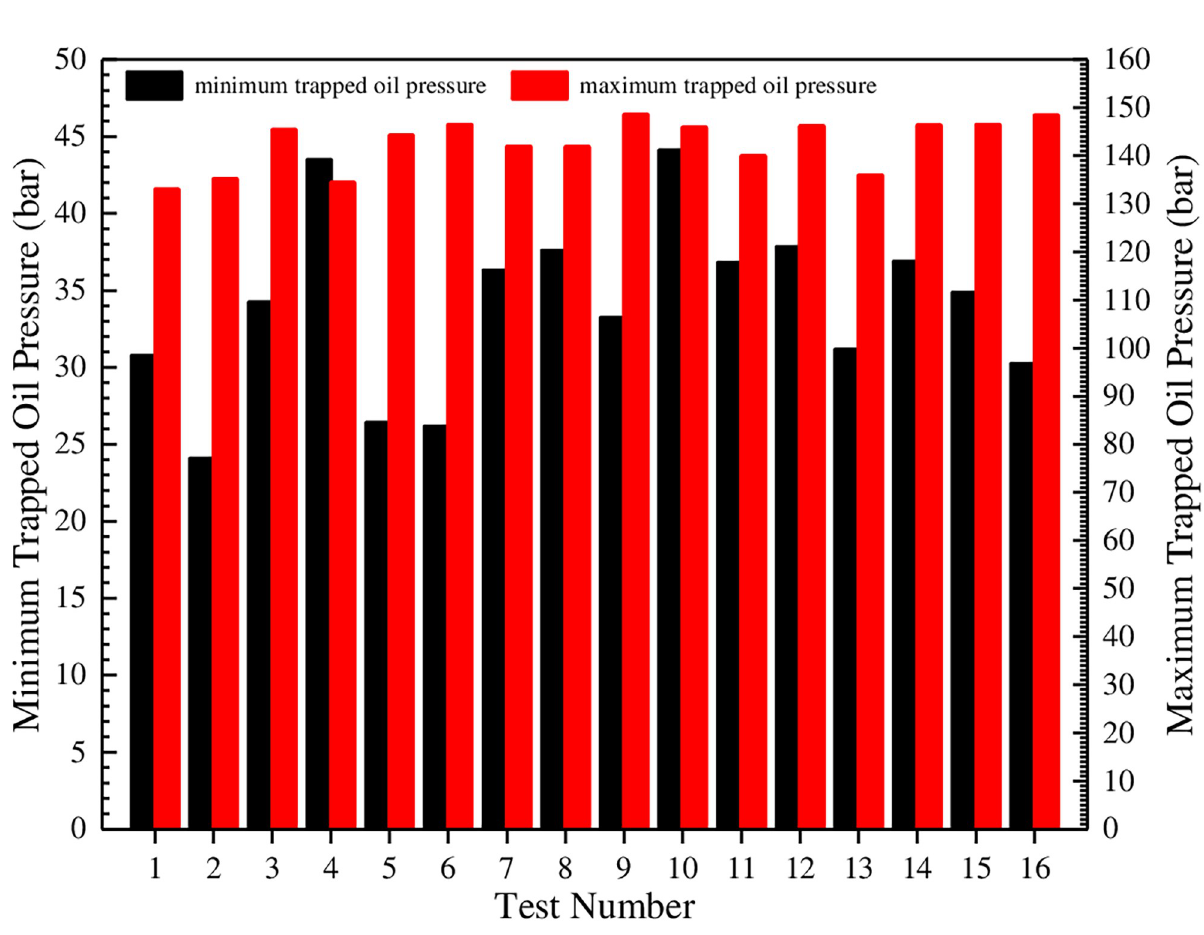
Fig 15. Comparison of the maximum and the minimum of trapped oil pressure under different test